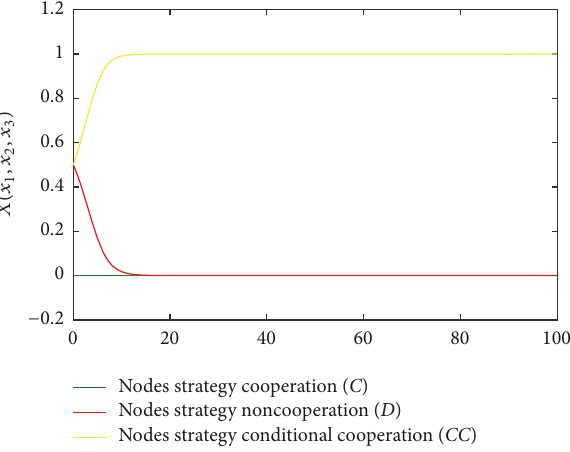
Figure 9: The state of population when 𝑥 = (0, 0.5, 0.5).